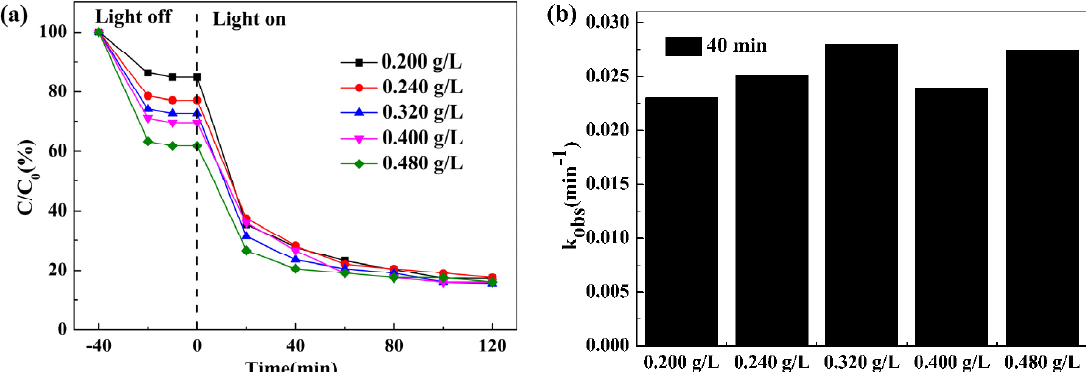
Figure 7. ( a ) The photocatalytic degradation and ( b ) rate constant of g-C 3 N 4 nanosheets, Zn 3 In 2 S 6 and binary x-ZIS/CN heterojunction (the dosage of catalyst = 0.200 g/L, C TC = 20 mg/L).